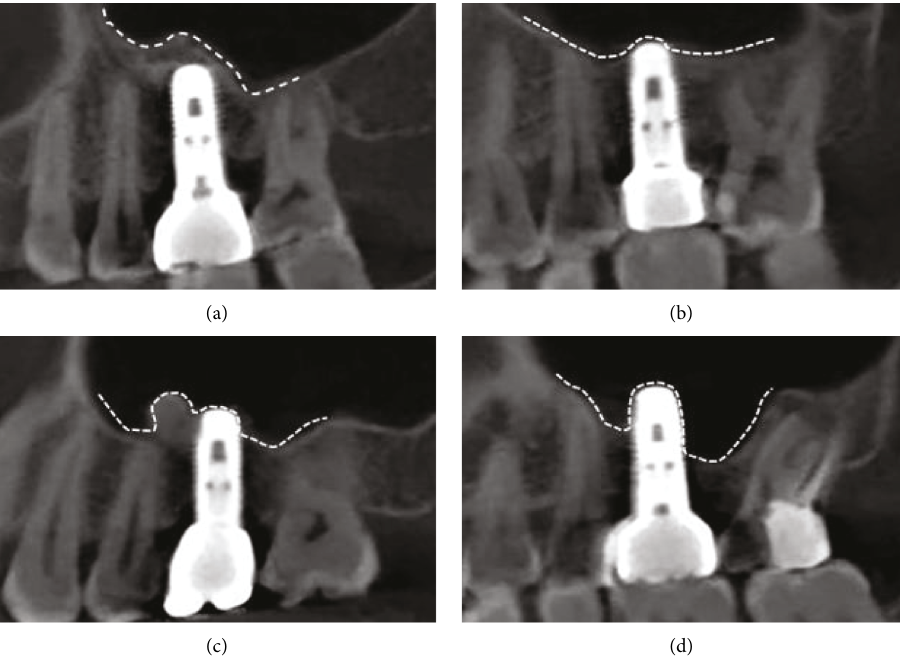
Figure 4: Classification based on the sagittal plane. (a) Type A: tent type; (b) Type B: flat type; (c) Type C: one-sided dehiscence type; (d) Type D: two-sided dehiscence